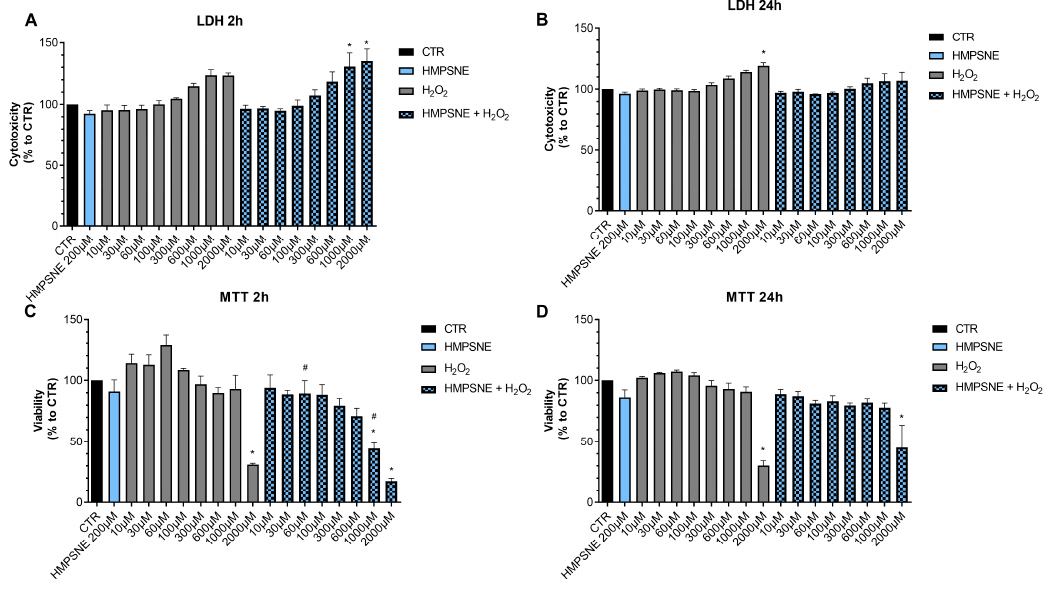
Figure 8. Effect of AOAA on the response to oxidative stress in EO771 cells. The CBS/CSE inhibitor (300 µ M) did not affect oxidative stress induced cell death/loss of cell viability measured by LDH release ( A , B ) or MTT conversion ( C , D ) in the presence of H 2 O 2 challenge, as assessed at 2 or 24 h. N = 3 independent experiments ± SEM. * p < 0.01 shows significant differences compared to untreated control values.